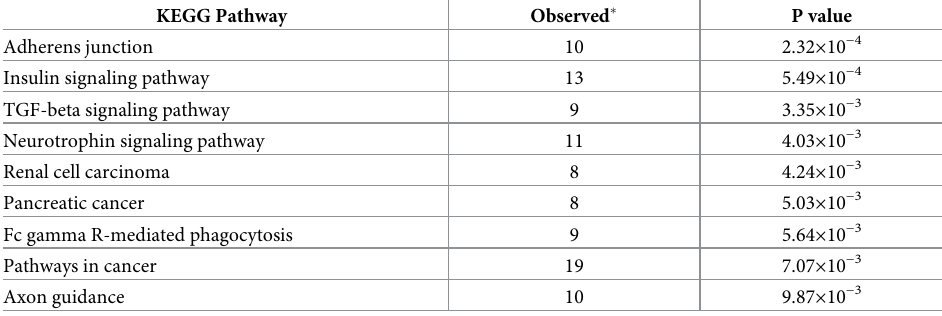
Table 3. KEGG pathways enriched with the target genes of bta-mir-655 by GO analysis (P < 0.01). KEGG